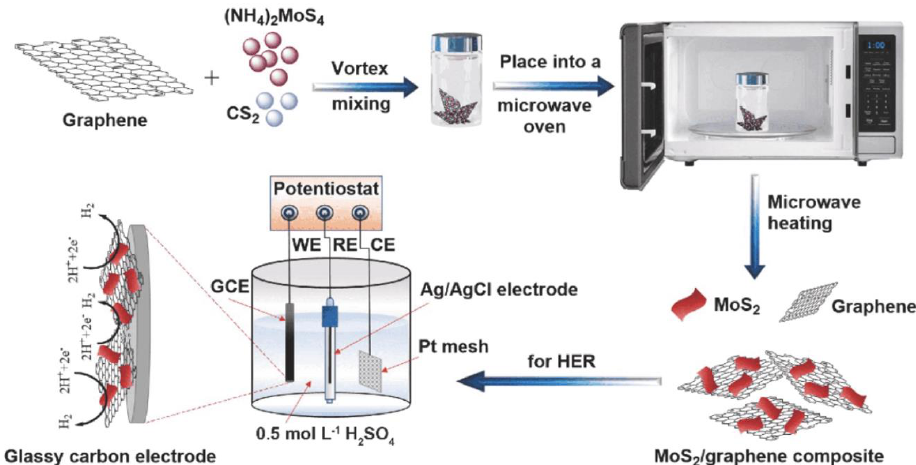
Figure 5. Schematic illustration of the microwave-assisted synthesis of the MoS 2 /graphene composite. Reproduced with permission from